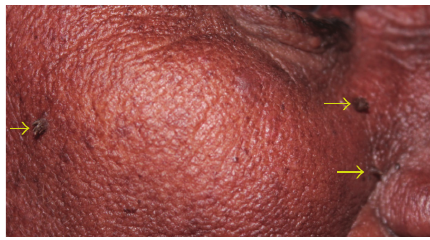
Figure 1: Multiple warts were seen involving face.